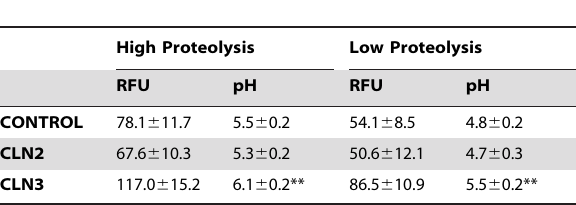
Table 1. Lysosomal pH values of control, CLN2 and CLN3 fibroblasts incubated in high and low proteolysis